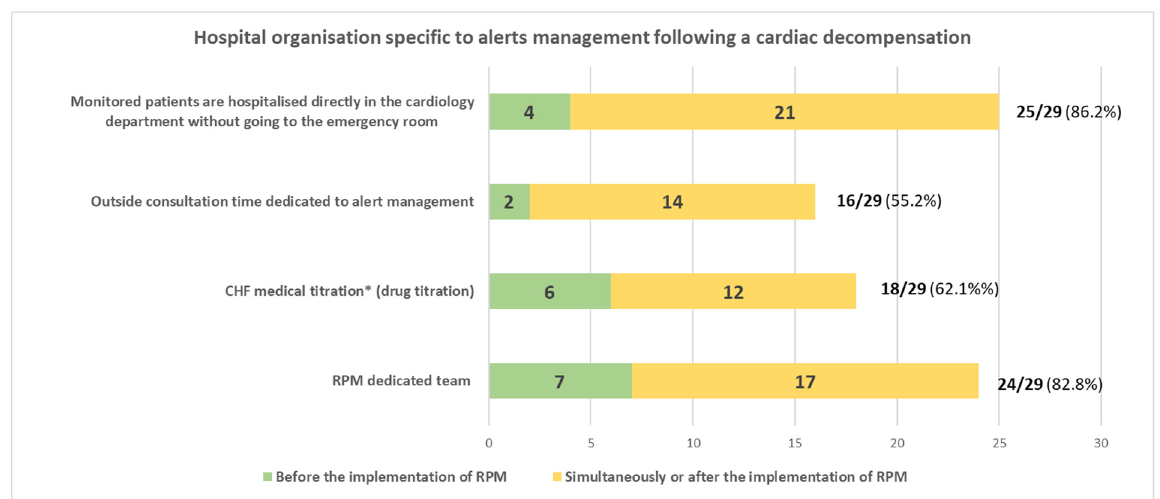
Figure 1. Specific organisational structures and procedures implemented in cardiology departments for alert management after decompensation of HF. * Titration of the dose of a drug in order to maximise its effectiveness without increasing the risk of adverse drug events, as recommended for patients with HF [11,12].